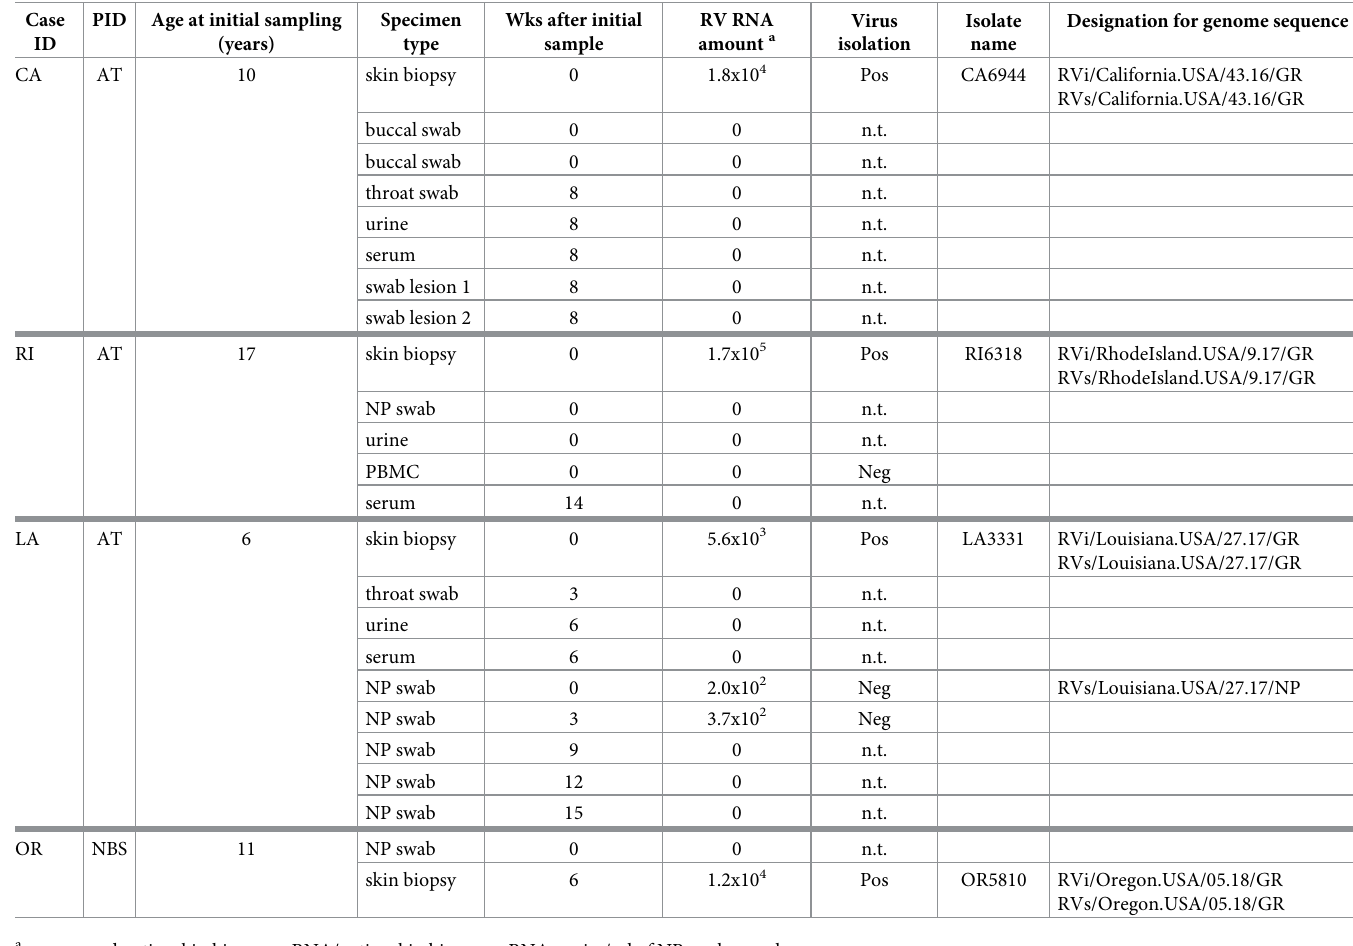
Table 1. Patient and sample information.